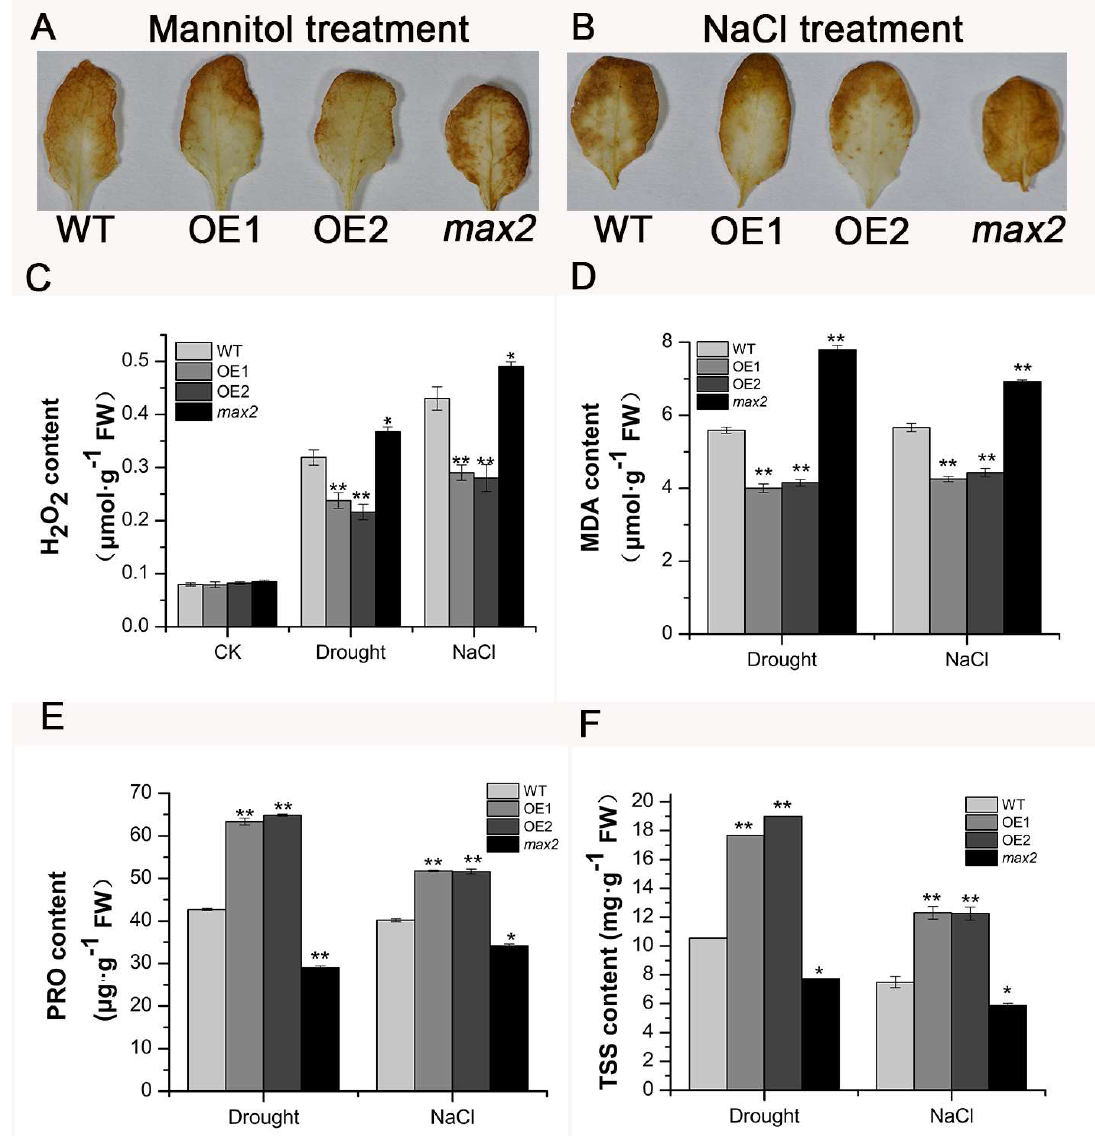
Figure 7. SsMAX2 OE lines exhibited lower hydrogen peroxide and malondialdehyde (MDA) levels and increased proline and soluble sugar levels in response to osmotic and salt stresses. ( A , B ) DAB staining of the leaves of SsMAX2 OE lines, max2 , and WT after mannitol and NaCl treatment. The ( C ) hydrogen peroxide, ( D ) MDA, ( E ) proline, and ( F ) soluble sugar level of 15-day-old seedlings of the SsMAX2 OE lines, max2 , and WT were determined 5 days after withholding water or 150 mM NaCl treatment. Data are presented as means ± SD of three biological replicates. Significant differences between WT and the other groups were determined by Student’s t -test. Significance level: * p < 0.05, ** p < 0.01.